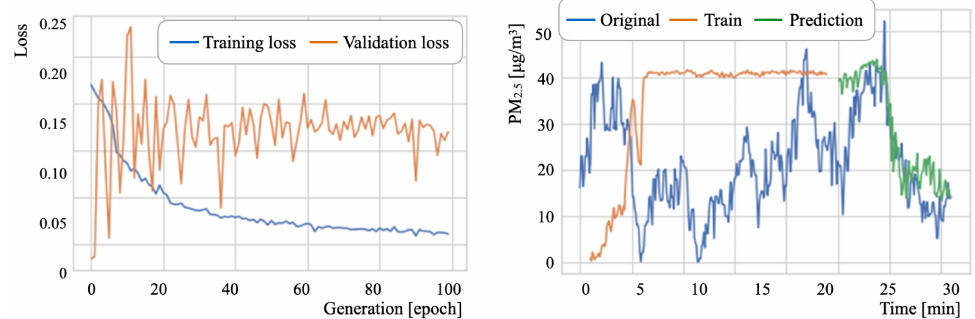
Figure 24. Loss curves and PM 2.5 prediction results for